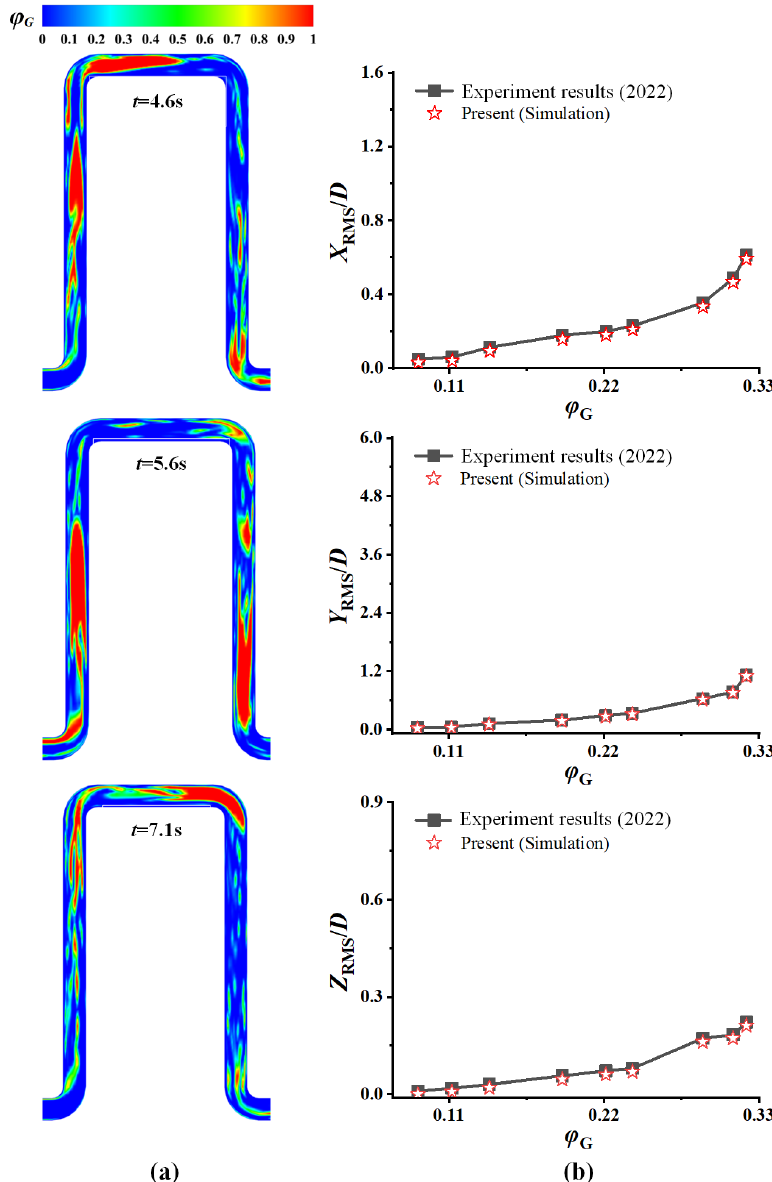
Figure 6. Model validation for the vibration response of a reversed U-shaped tube against the experimental results reported by Bamidele et al. [40]: ( a ) comparison of the flow pattern morphology between the present CFD simulation and the experiment at v air = 0.51 m/s and v water = 0.46 m/s; ( b ) the root-mean-squared displacements of the upper right bend in three